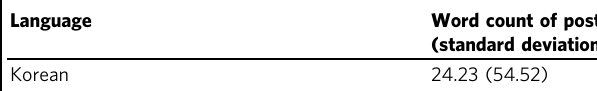
Table 6 Data description of Everytime dataset.